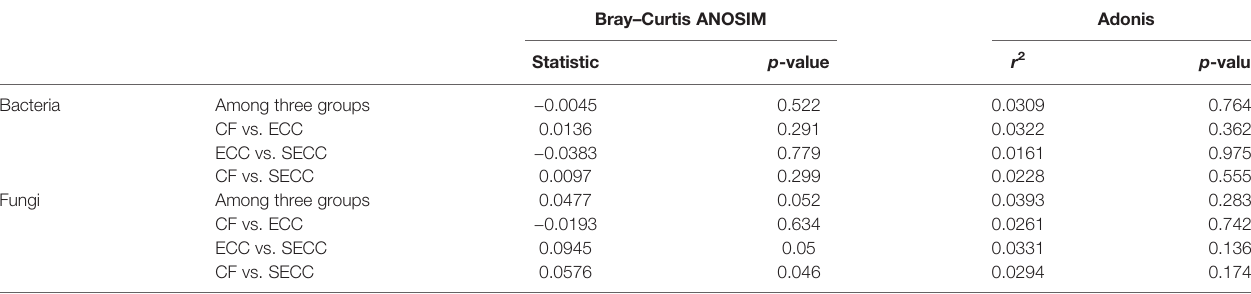
TABLE 2 | The calculations and p -values of ANOSIM and Adonis of salivary bacteria and